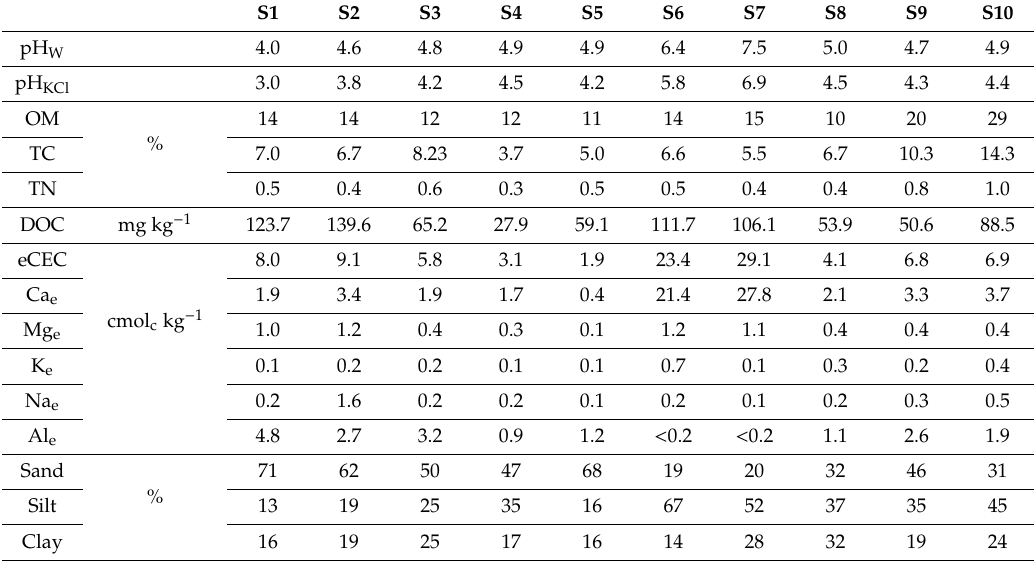
Table 1. Main physicochemical properties of the soil